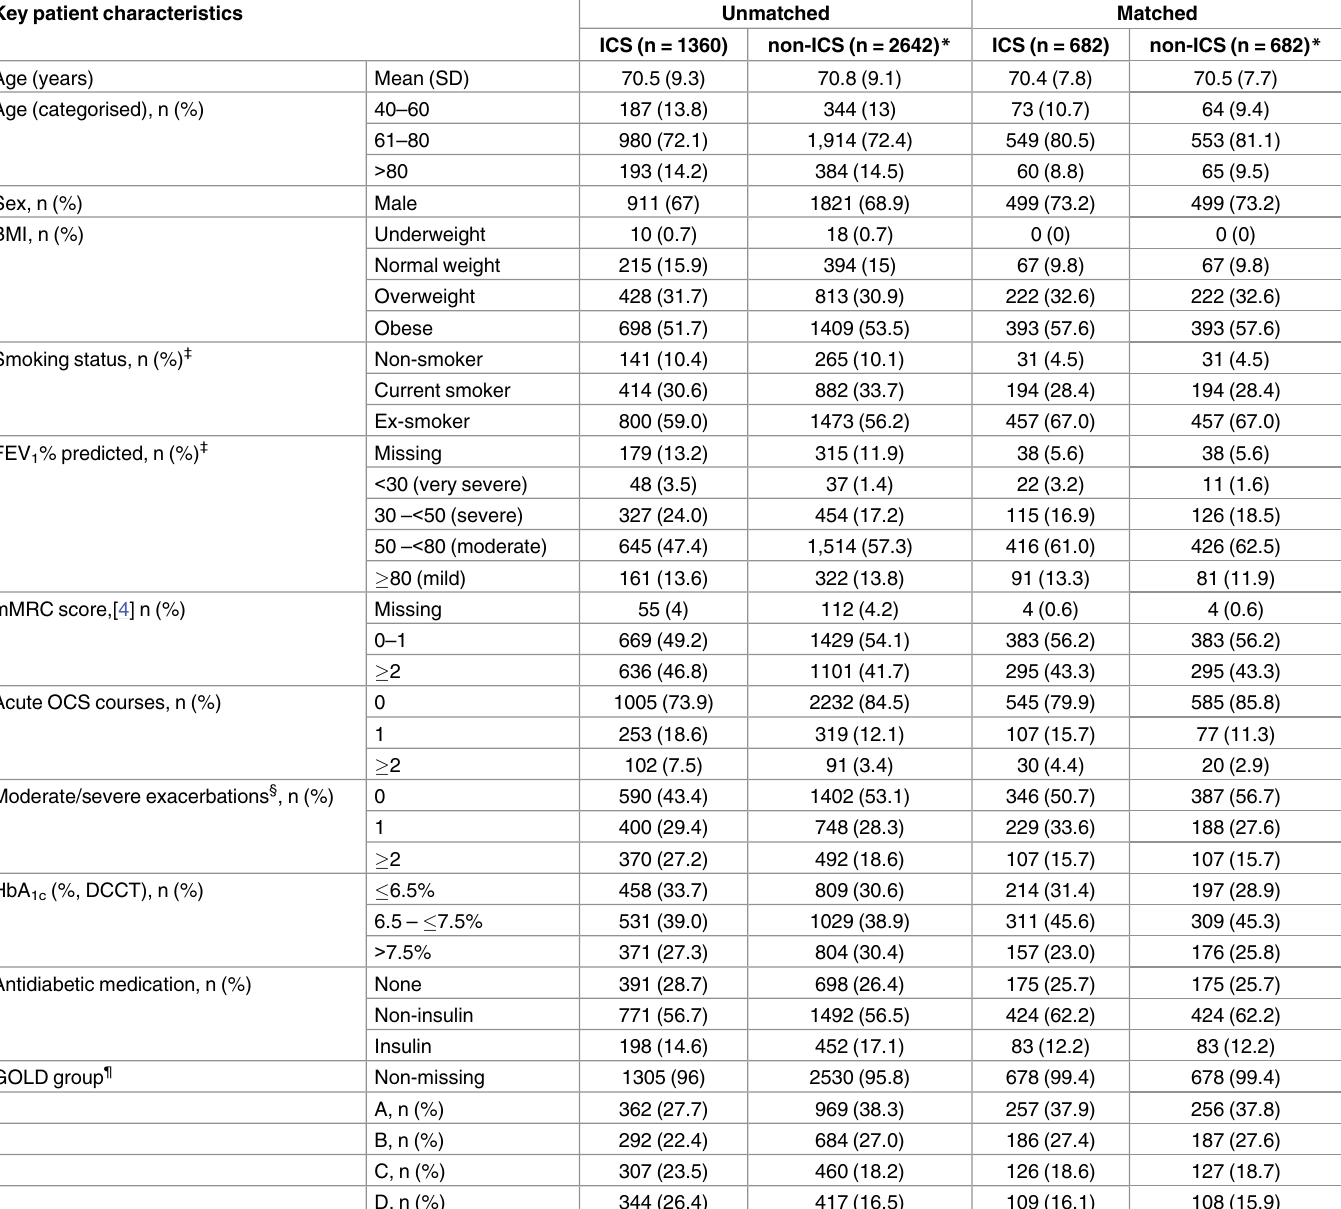
Table 2. Key baseline demographic and clinical characteristics for unmatched and matched datasets comparing patients with COPD and type 2 diabetes on either ICS or non-ICS therapy. Additional baselinedata can be found in S1 Table (S1 File). Key patient